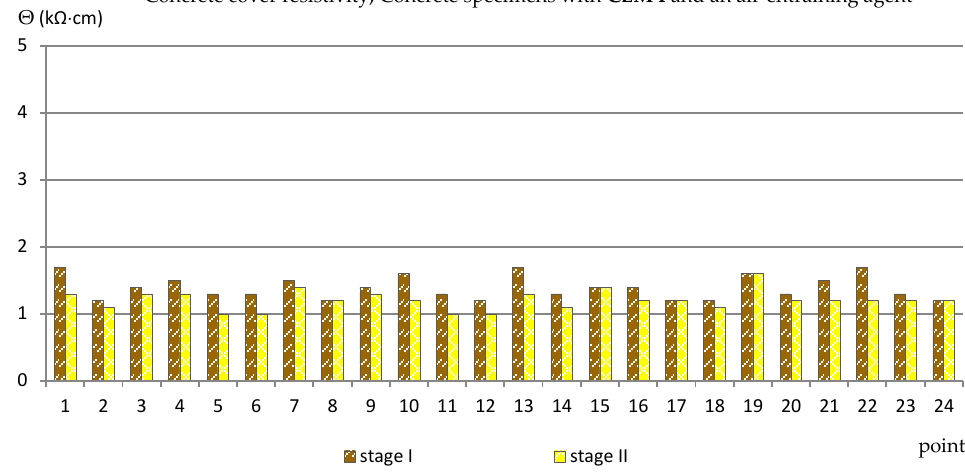
Figure 11. Concrete cover resistivity measured in C_I_a specimens.